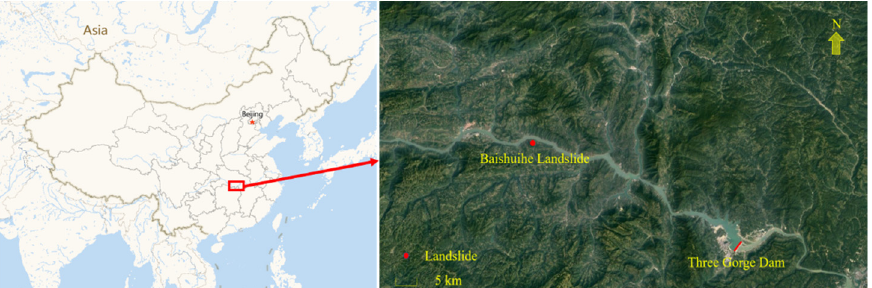
Figure 3. The geographical location of Baishuihe landslide.